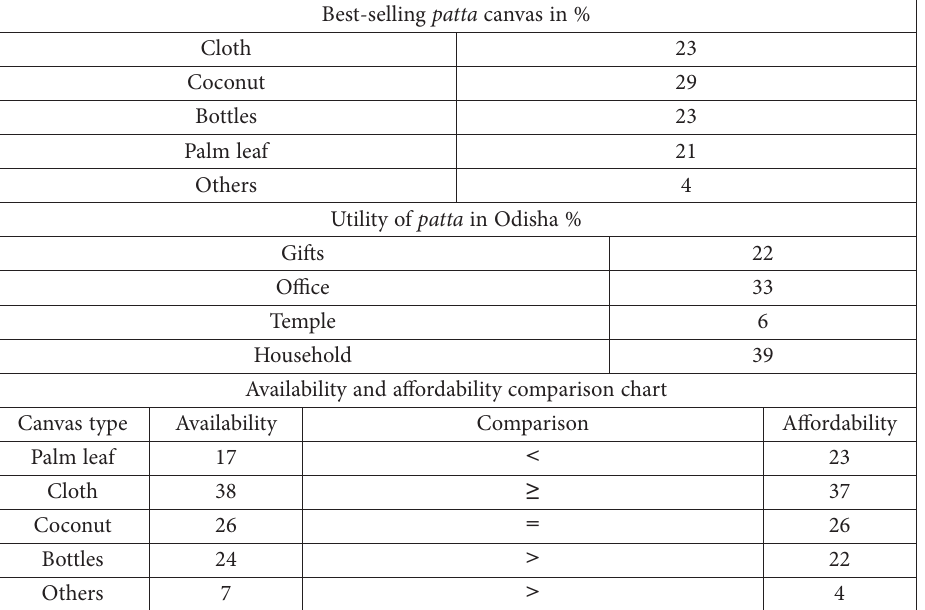
Table 2. Profile of changing trends in pattachitra (source: created by